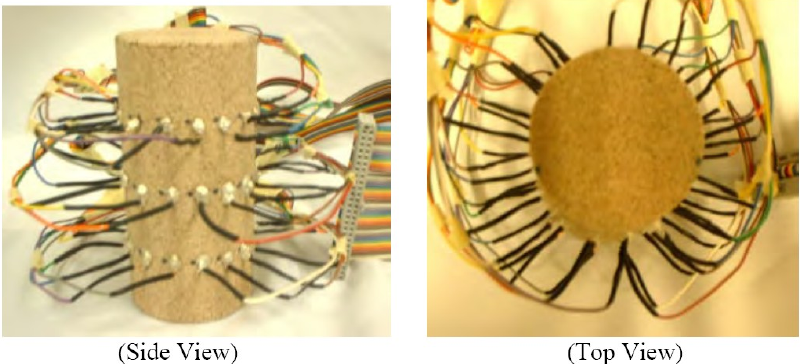
Figure 9. Side and top view of the electrode design.